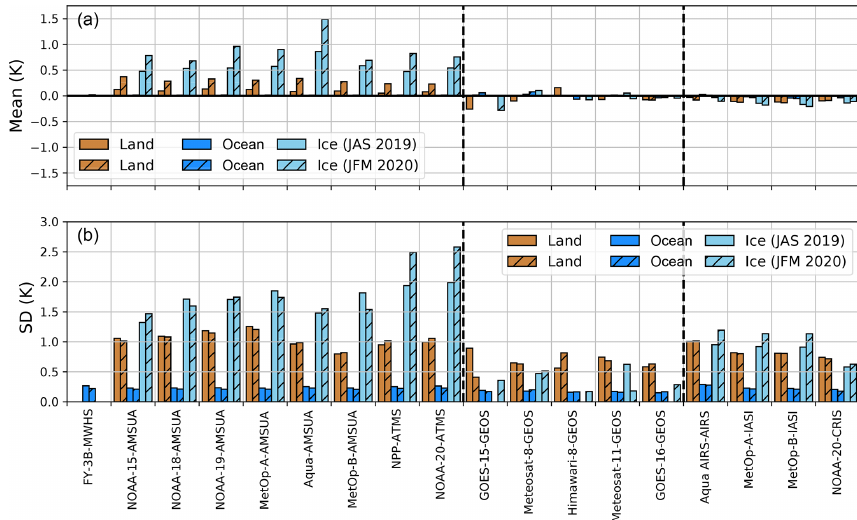
Figure 3. Mean (a) and standard deviation (b) of the skin temperature analysis difference between the SKTECV and the TOVSCV experi- ments for each instrument and for the two seasons: JAS 2019 (colour) and JFM 2020 (hatched colour). The difference is computed over the ocean, sea ice, and land (see legend). The left part of the plot shows the microwave instruments, the middle part of the plot shows the infrared instruments (geostationary), and the right part of the plot shows the infrared instruments (polar